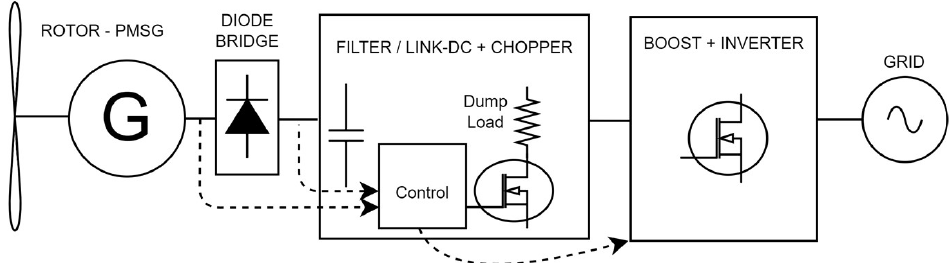
Figure 3. Grid-connected PMSG-based small wind turbine system.